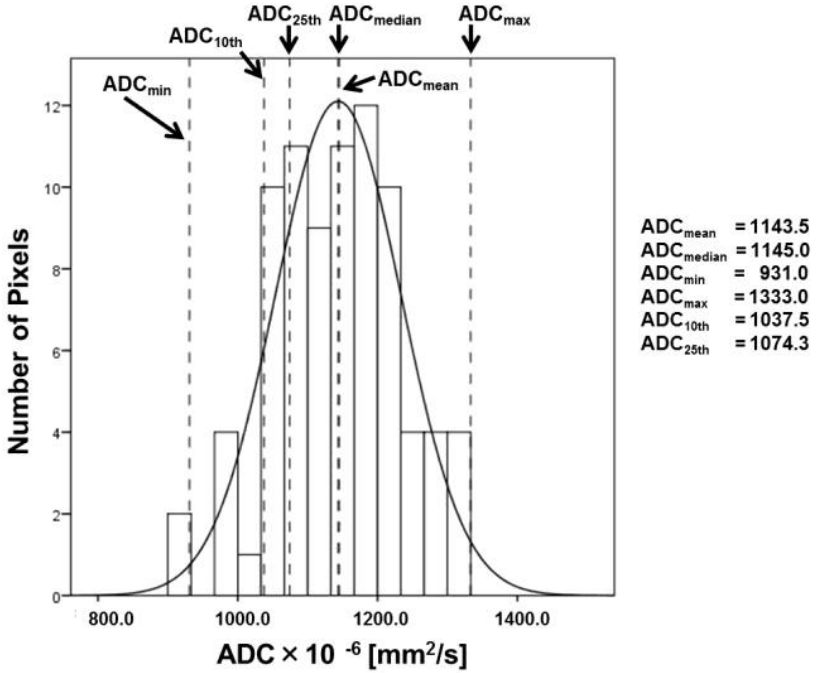
Figure 1. Typical histogram analysis of prostate cancer (Gleason score = 7) using the six histogram- derived ADC parameters. The mean (1143.5 × 10 − 6 mm 2 /s), median (1145.0 × 10 − 6 mm 2 /s), minimum (931.0 × 10 − 6 mm 2 /s), maximum (1333.1 × 10 − 6 mm 2 /s), and 10th (1037.5 × 10 − 6 mm 2 /s) and 25th (1074.3 × 10 − 6 mm 2 /s) percentile ADC values were determined from the ADC histogram.